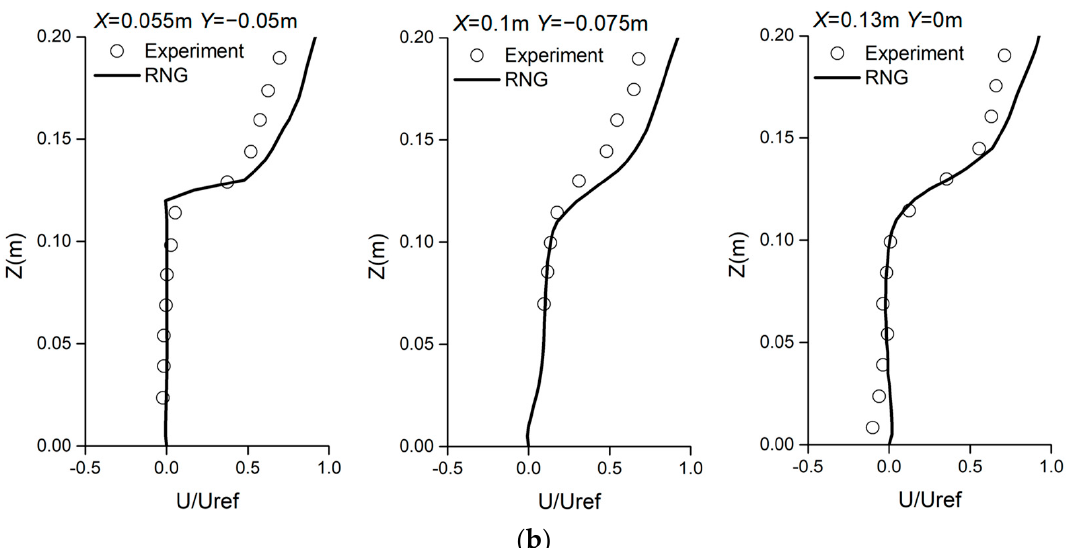
Figure 2. Comparison between grid − independent solution verification and experiment data. ( a ) Comparison of mean velocity profiles using three types of mesh systems at the vertical line. ( b ) Comparison of mean velocity profiles using medium grid and experiment data at the vertical line.